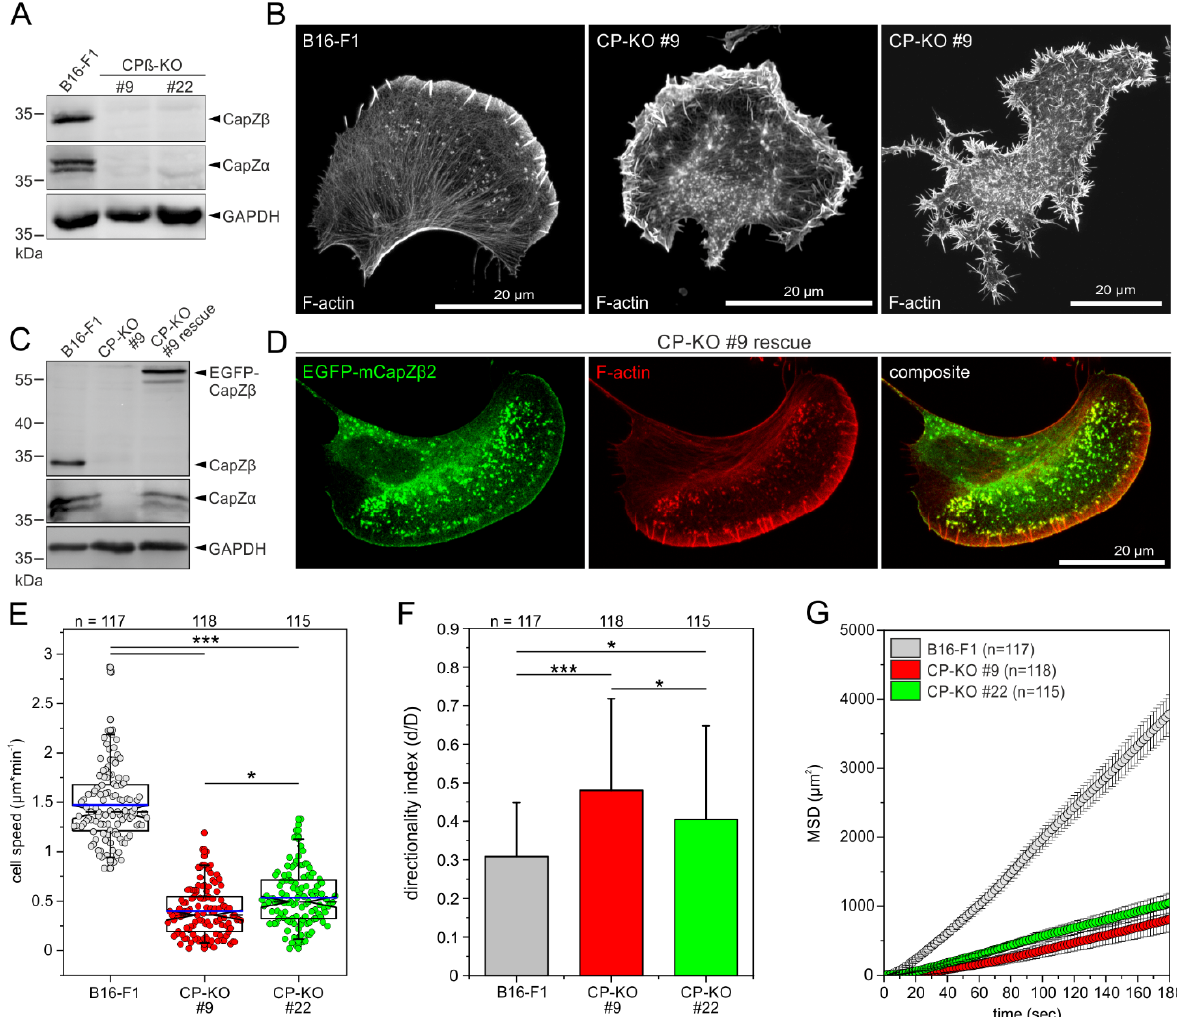
Figure 1. Loss of CP in B16-F1 cells triggers the massive formation of filopodia and impairs 2D-cell migration. ( A ) Immunoblot confirming the elimination of CP-ß in two independent single-knockout B16-F1 mutants (clones #9 and #22). The loss of the ß-subunit also led to the almost complete loss of the α -subunit. Loading control: GAPDH. ( B ) Morphology of representative B16-F1 cells with a smooth leading edge and embedded microspikes (left) and of CP-KO mutants that were either polarized and exhibited strong ruffling of the leading edge (middle) or were unpolarized (right). Cells migrating on laminin were stained for F-actin with phalloidin. Note the dramatically increased formation of filopodia in the mutant cells. ( C , D ) Reconstitution of CP-KO cells with EGFP-tagged CP-ß restores expression of the CP- α -subunit ( C ) and rescues the phenotype ( D ). ( E ) Loss of CP in B16-F1 cells decreases random 2D-cell migration on laminin. At least three time-lapse movies from three independent experiments were analyzed for each cell line. The boxes in box plots indicate 50% (25–75%) and whiskers (5–95%) of all measurements, with dashed black lines depicting the medians and arithmetic means highlighted in blue. ( F ) Directionality increased upon inactivation of CP. Bars represent arithmetic means ± SD. ( G ) Analyses of mean square displacement of wild-type versus mutant cells. Error bars represent means ± SEM. ( E , F ) Non-parametric, Kruskal–Wallis test and Dunn’s Multiple Comparison test were used to reveal statistically significant differences between datasets. * p ≤ 0.05, *** p ≤ 0.001; n.s.: not significant. n: number of cells analyzed from at least three independent